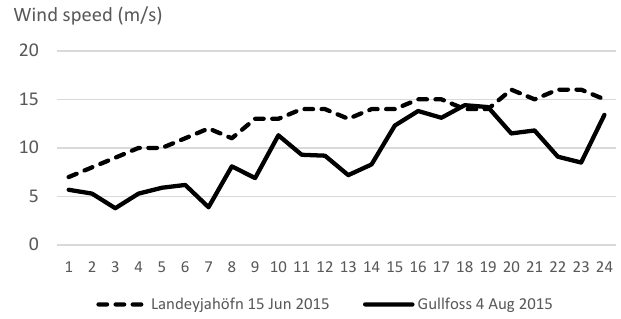
Figure 2. Observations of mean 10 min wind speed from 01-24 UTC at Landeyjahöfn (at the dust source for Storm 1) on 15 June 2015 and at Gullfoss (about 15 km SE of the dust source for Storm 2) on 4 August 2015.